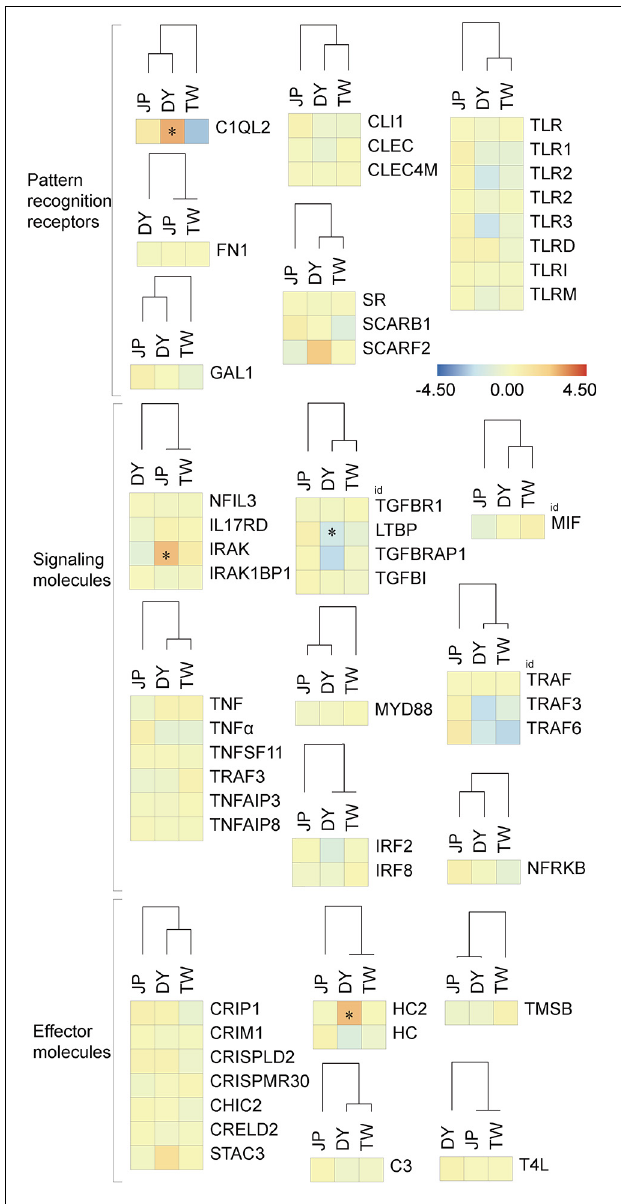
FIGURE 9 | Relative expression of immunity-related genes in the three H. diversicolor genotypes. * represents the significant difference of the gene expression level compared to the